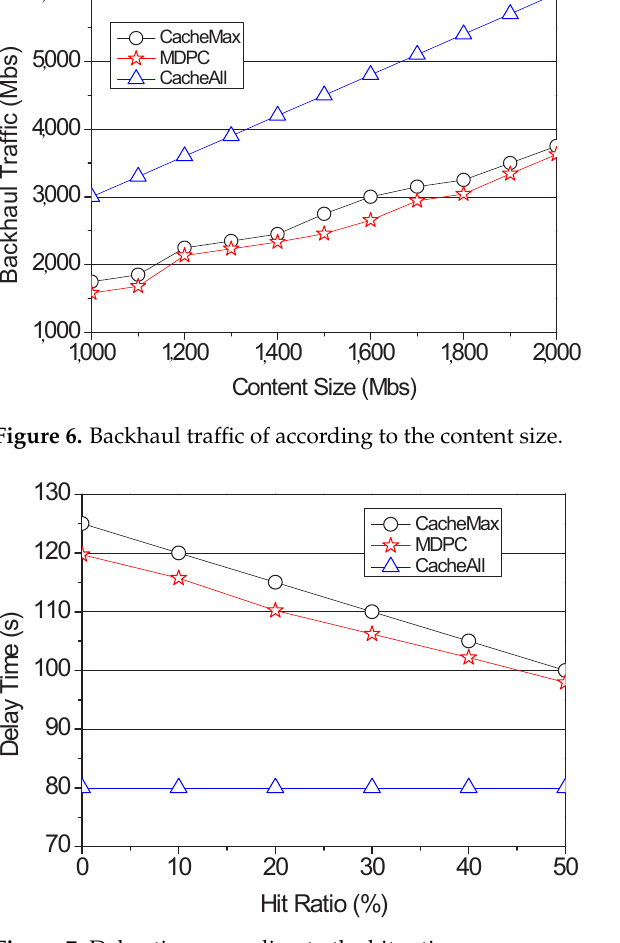
Figure 7. Delay time according to the hit